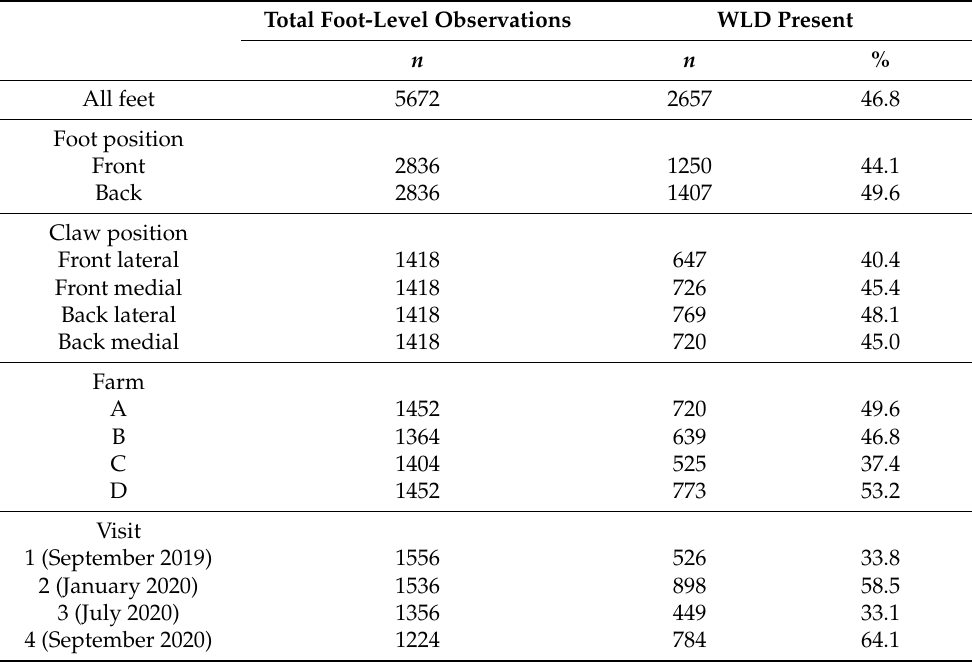
Table 5. Distribution of white line disease for 5672 foot-level observations of 400